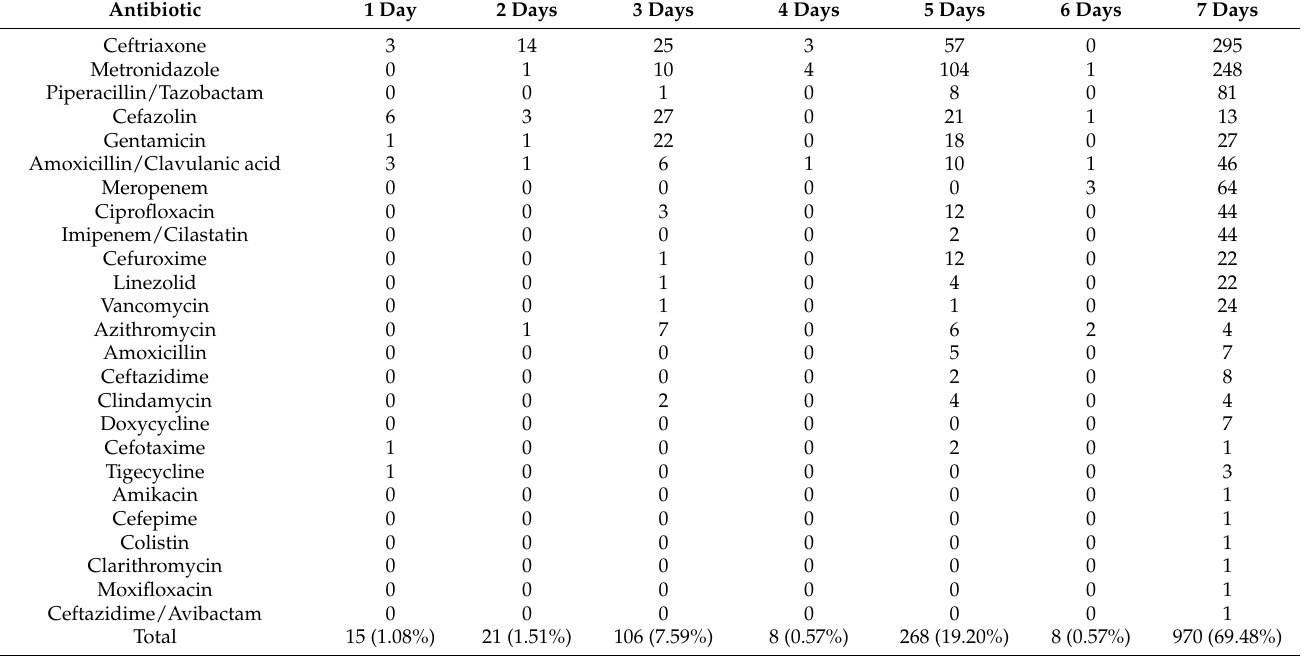
Table 4. The duration of the use of antibiotics in the surgical